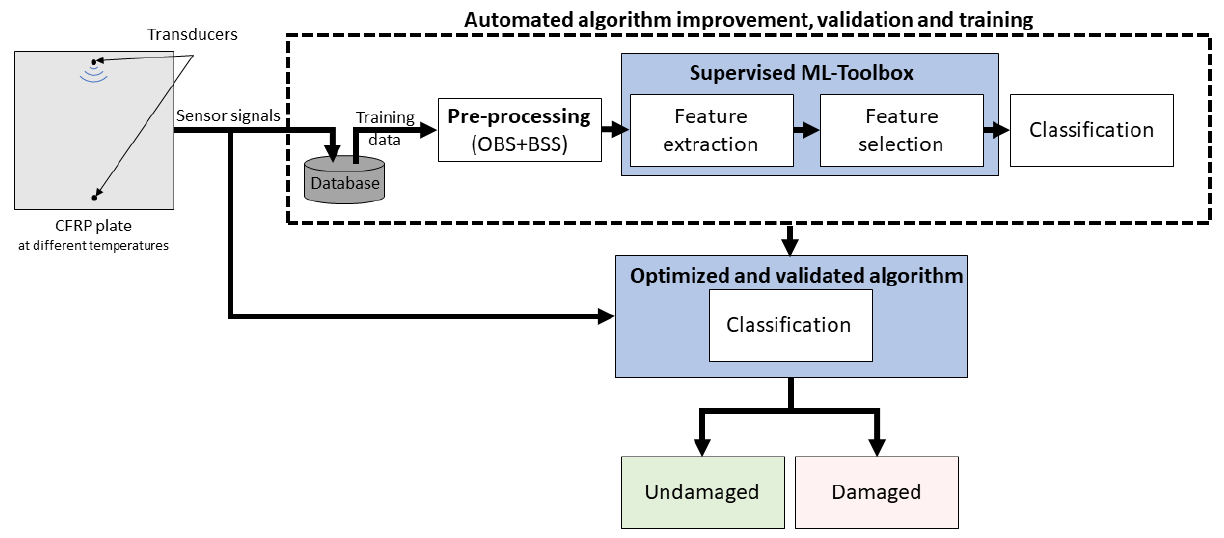
Figure 4. Flowchart illustrating the ML framework and the decision-making strategy.